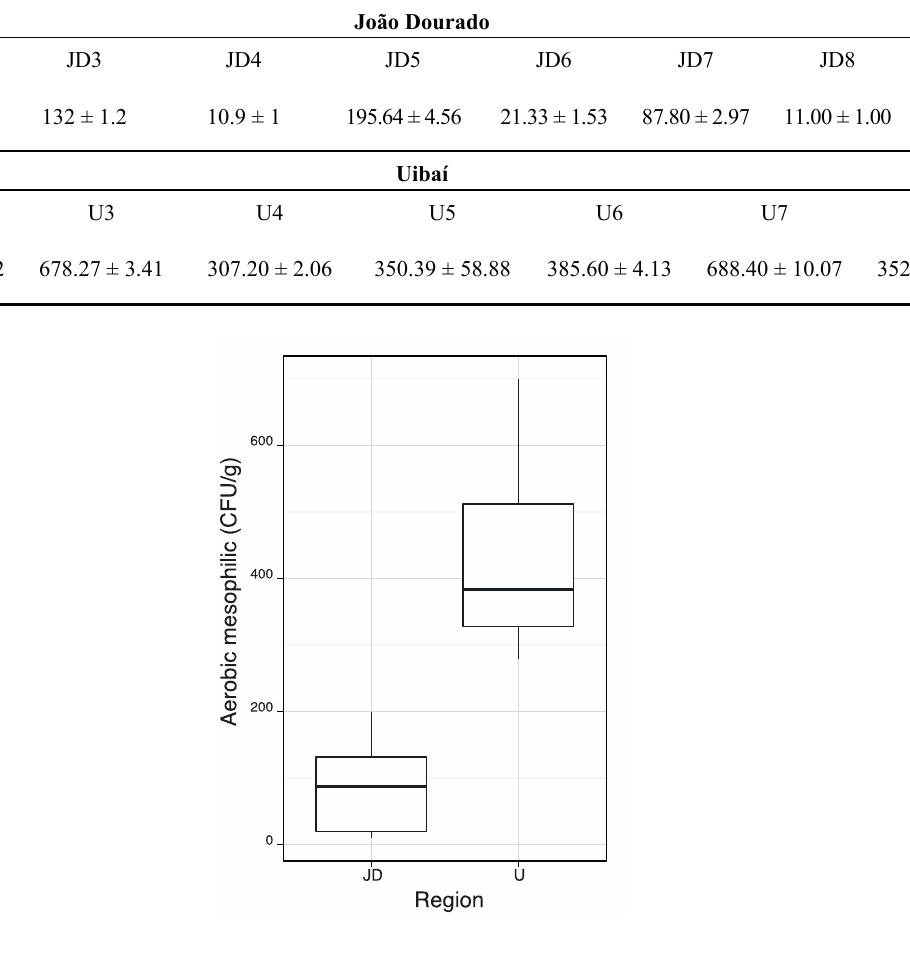
Figure 1. Boxplot for aerobic mesophilic